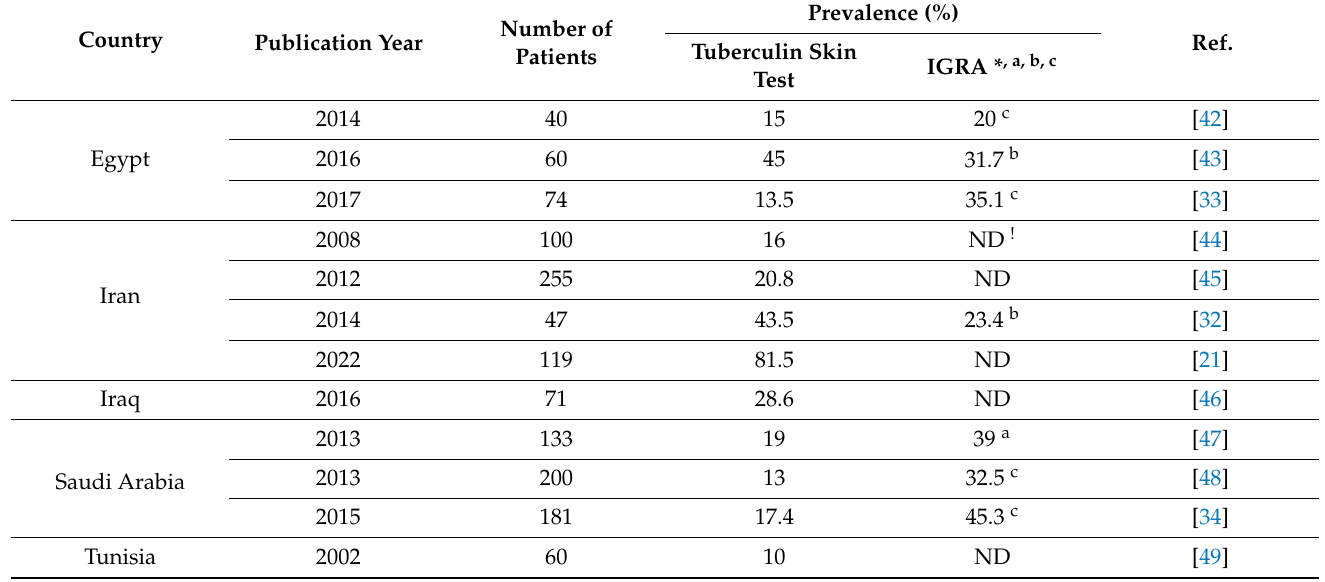
Table 3. Prevalence of latent tuberculosis infection among hemodialysis patients in the Middle East and North Africa (MENA)